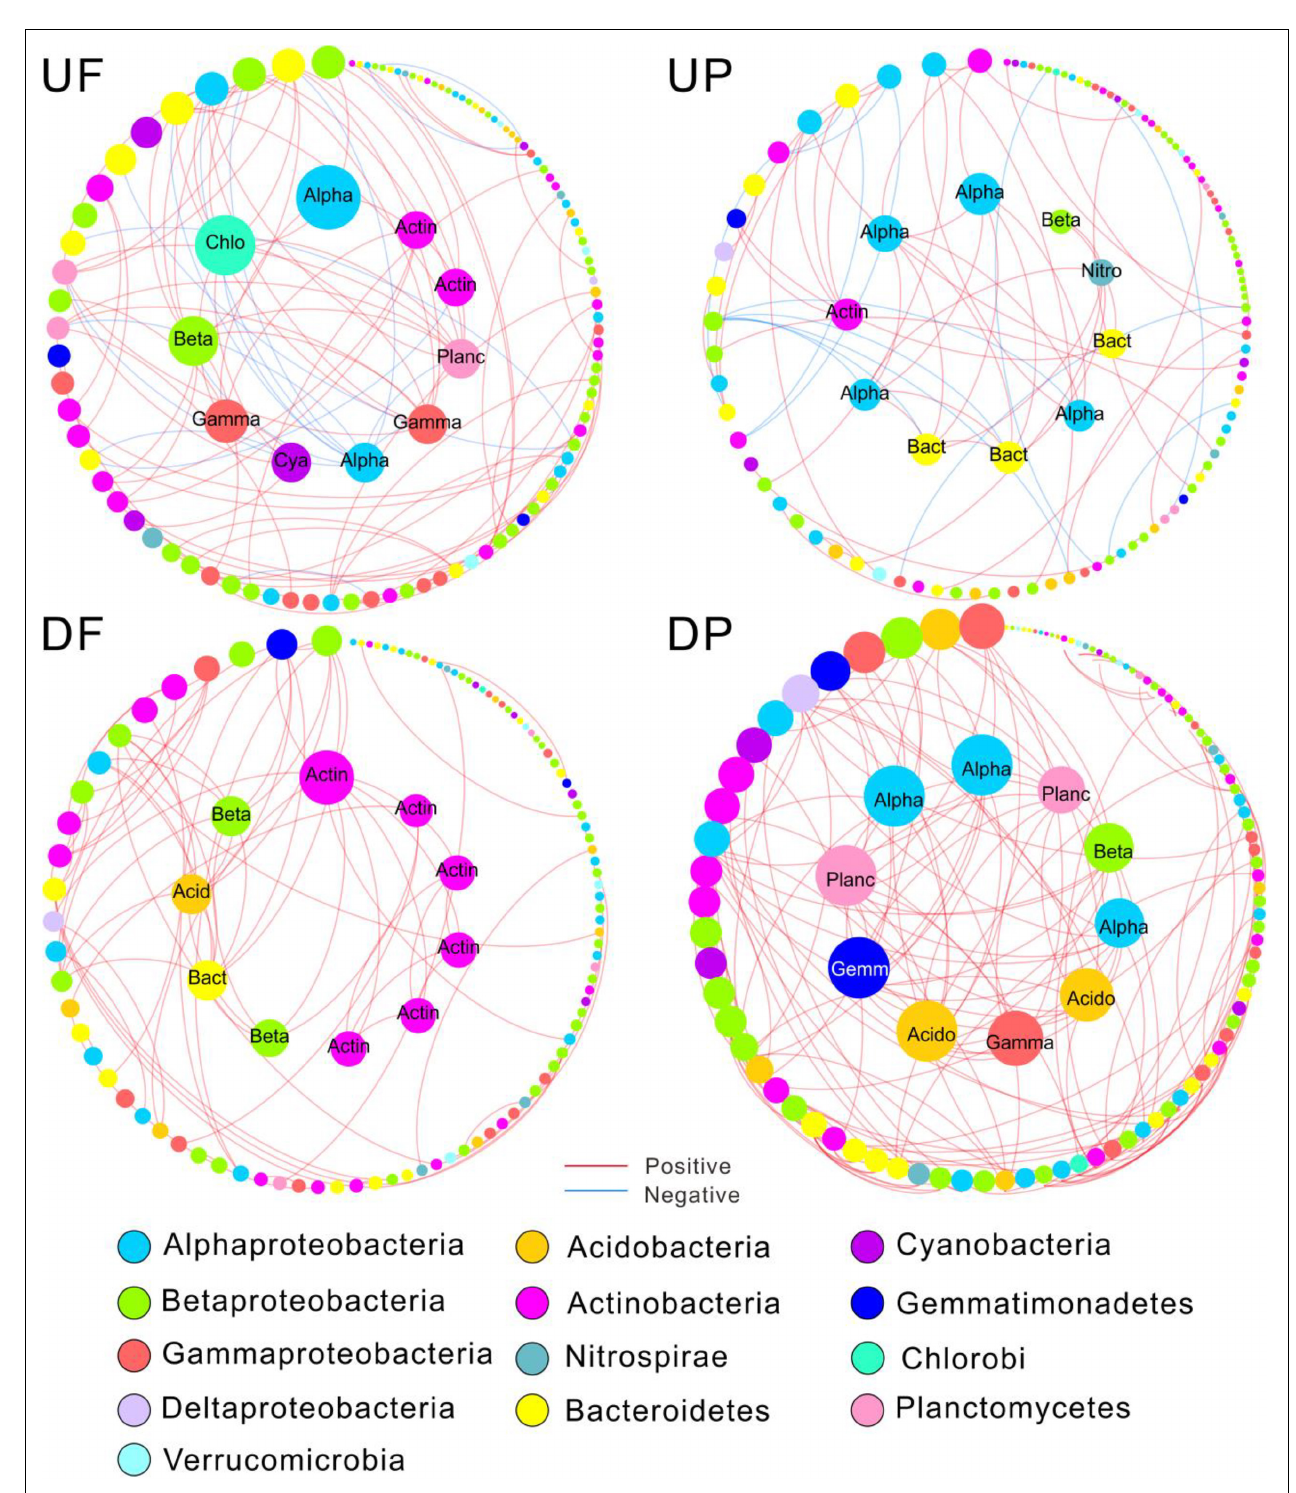
FIGURE 4 | Sub-networks for the 112 shared operational taxonomic units (OTUs) persistent in the four networks. The node size was constant with the overall networks, proportional to node degree. Edges were only kept those among the shared nodes. The top 10 OTUs with the highest node connectivity are shown in inner circles and marked with taxonomic affiliation. Alpha, Alphaproteobacteria; Beta, Betaproteobacteria; Gamma, Gammaproteobacteria; Chlo, Chloroflexi; Cya, Cyanobacteria; Acid, Acidobacteria; Actin, Actinobacteria; Bact, Bacteroidetes; Planc, Planctomycetes; Gemm, Gemmatimonadetes; Nitro, Nitrospirae; UF, free-living network for upstream; UP, particle-attached network for upstream; DF, free-living network for downstream; DP, particle-attached network for downstream.